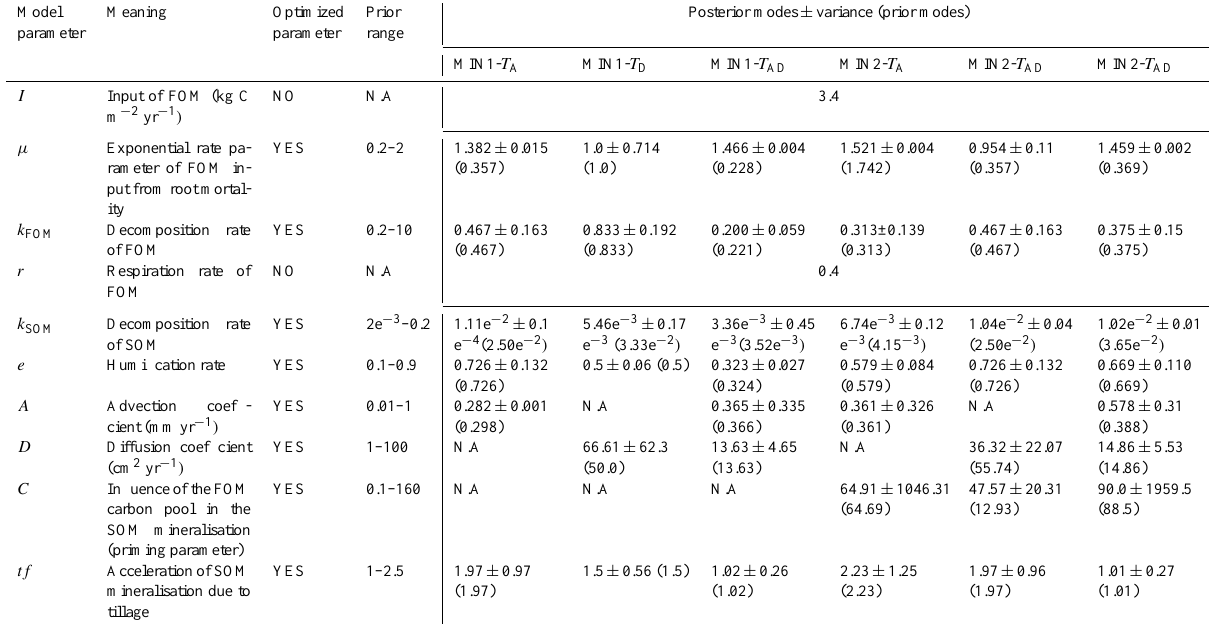
Table 1. Model parameters summary for the model MIN1- T A , MIN1- T D , MIN1- T AD , MIN2- T A , MIN2- T D , MIN2- T AD .